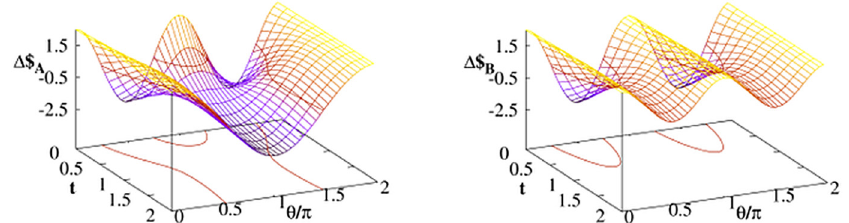
Fig 1. Payoff differences Eq (29) taken at different time instances t for Alice – Bob strategy profile ( I , I U ) with the quantum strategy Eq (12) with U = U ( π /2,0, π /2). The thermal Davies environment (with A = 2 G = 2) influences only one player (either Bob or Alice) and p = 0. The contours denote the border between positive and negative payoff difference.